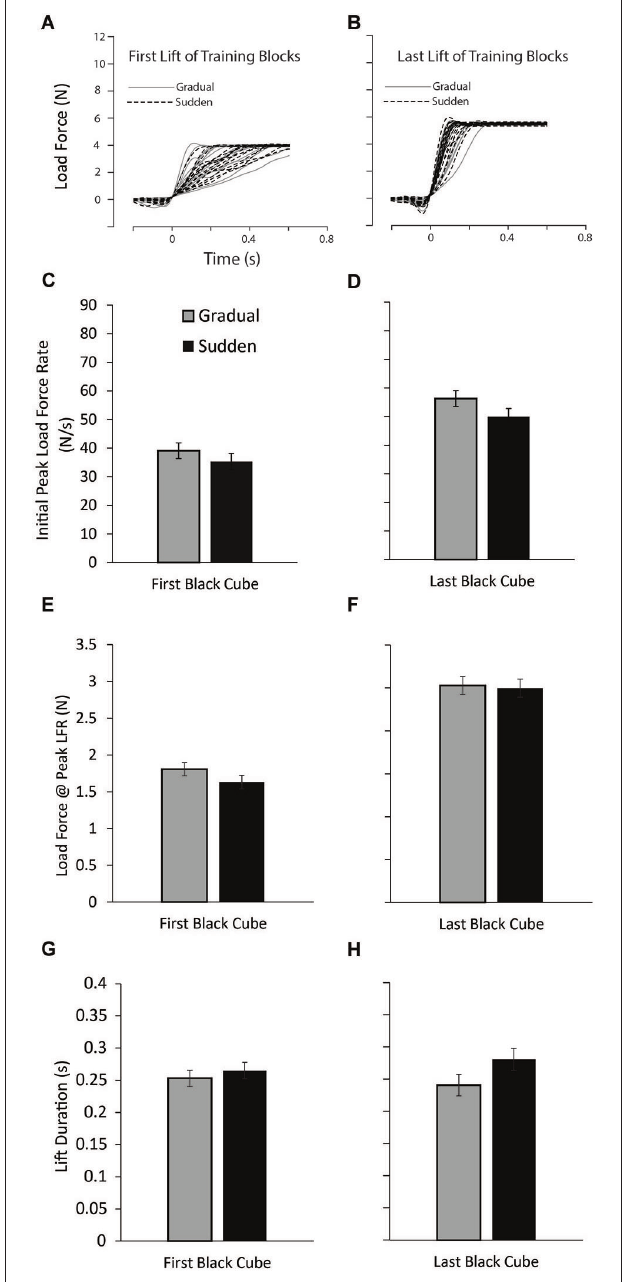
FIGURE 2 | Lift performance on the training blocks. (A) Load force records as a function of time from the first lift of the training block for all participants in both the sudden (black dashed line) and gradual (solid gray line) lifting conditions. (B) Load force records for the last lift of the training block for all participants. (C–H) Mean initial peak load force rate (PeakLFR) ( C and D ), load force at initial peak in load force rate ( E and F ), and load phase durations (LPD) ( G and H ) averaged across participants, for the first ( C , E , and G ) and last ( D , F , H ) of the lifts of the training blocks. Vertical lines represent ± 1 standard